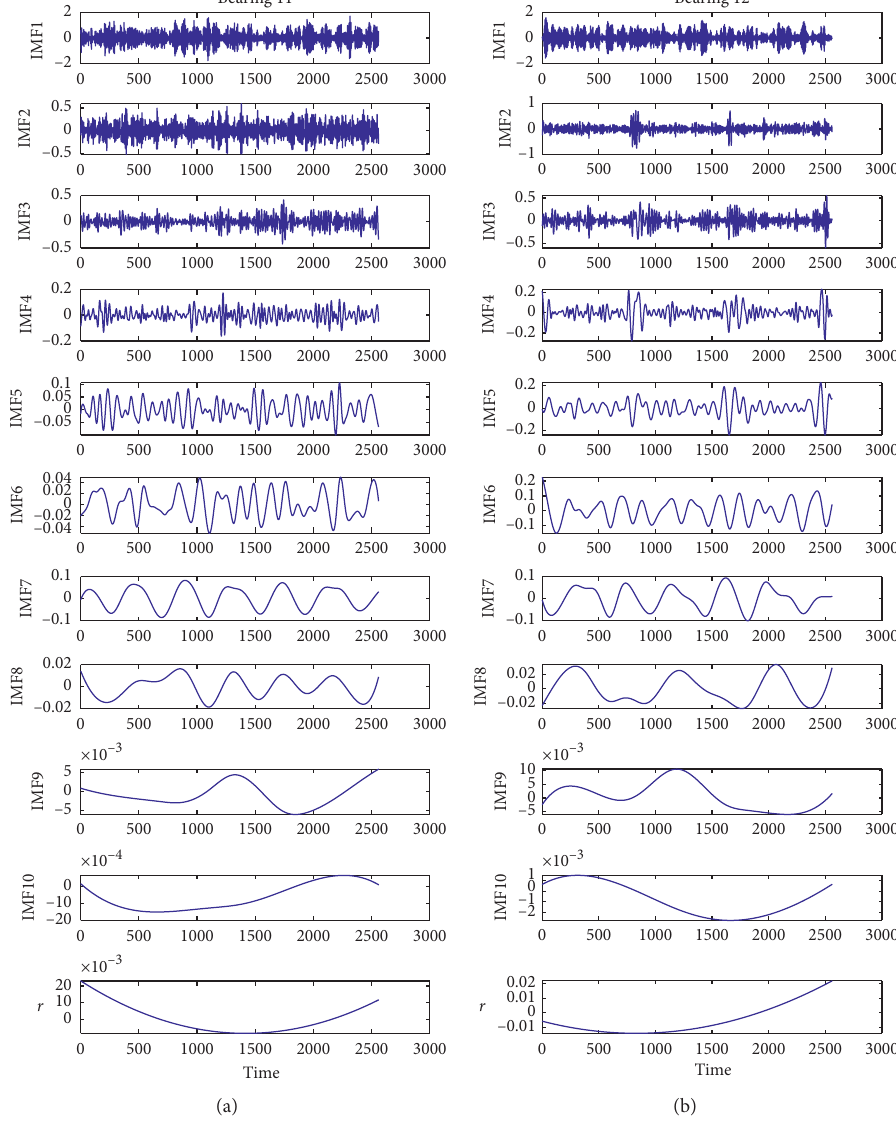
Figure 22: Results of IMFs when using EEMD for bearings (a) 11 and (b)